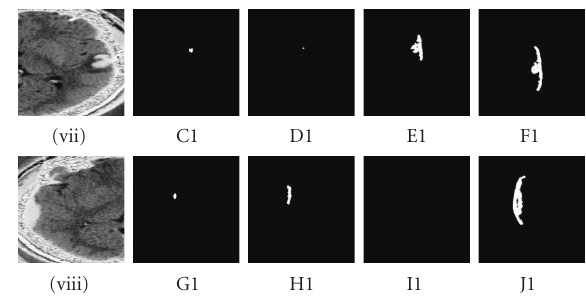
Figure 3: (C1, G1) distance = 3, α = − 0 . 25, σ = 0 . 45, β = 1 . 85, propagation = 0 . 005, curvature = 0 . 9, (D1, H1) distance = 5, α = −